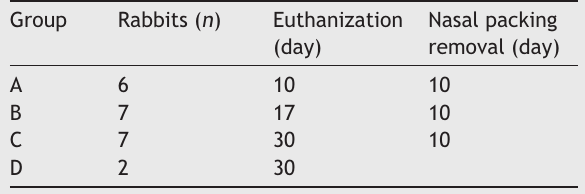
Table 1 Description of the groups of animals, number of rabbits and euthanization days and removal of nasal